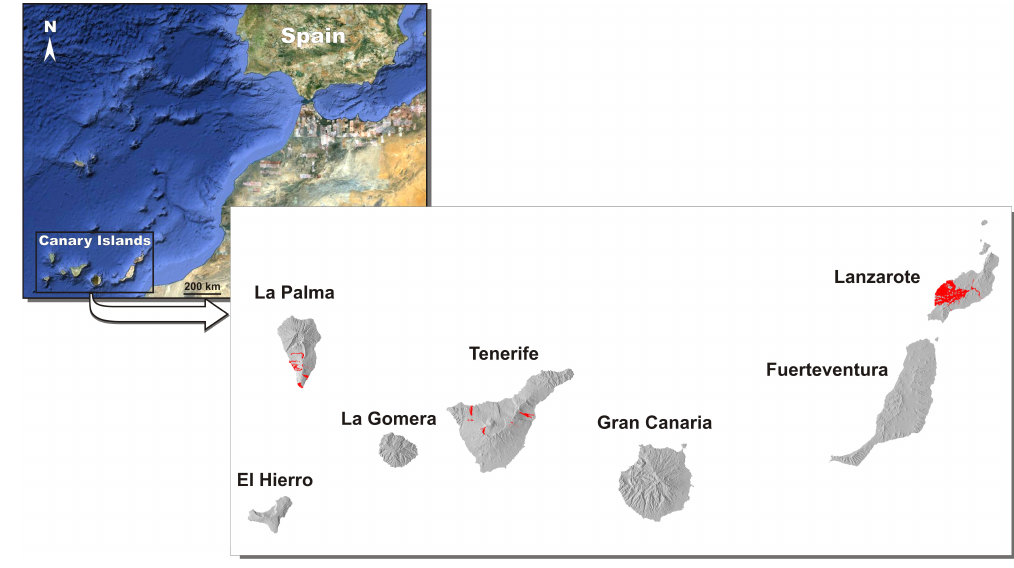
Fig. 1. Distribution of historical volcanism in the Canary